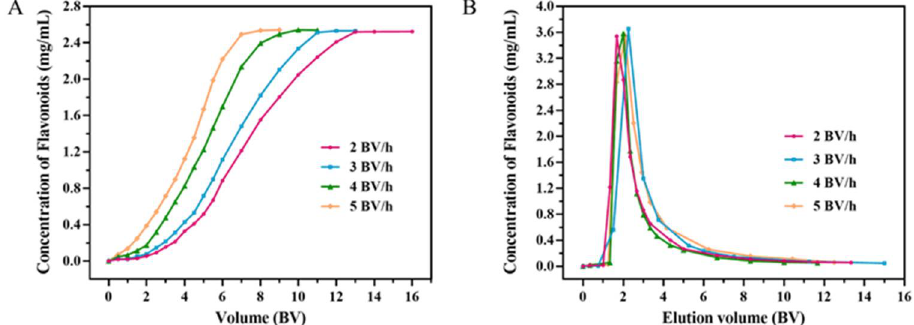
Figure 2. Dynamic breakthrough curves ( A ) and dynamic desorption curves ( B ) of TFs in crude extracts on HP20 resin column at various flow rates.